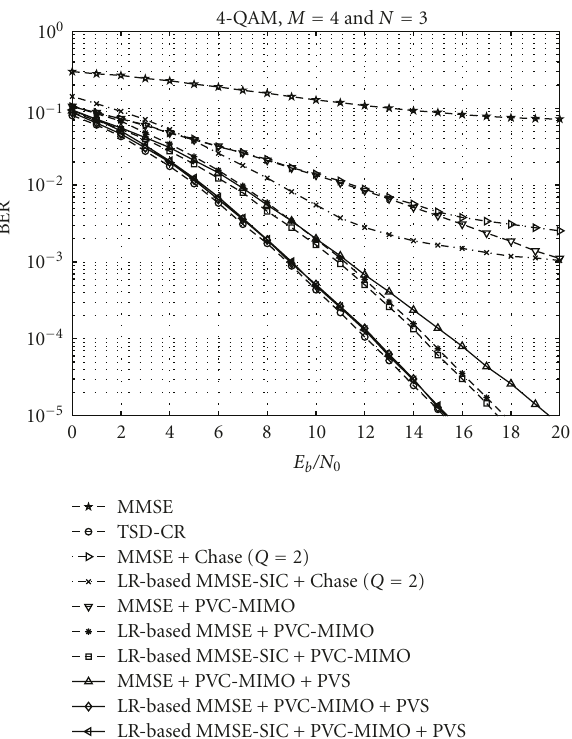
Figure 2: BER versus E b /N 0 of di ff erent detectors represented in Section 5.1 for 4-QAM, M = 4, N = 3.